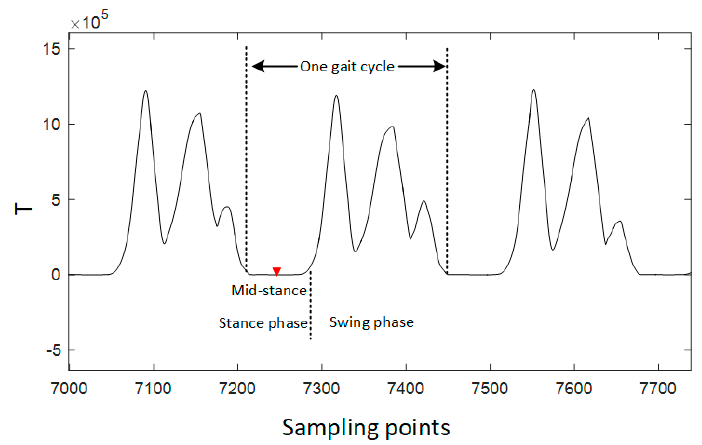
Figure 12. Relationship of mid-stance, stance phase, swing phase and gait cycle. Mid-stance can be expanded to stance phase using stance phase duration information. T is the test statics of SHOE detector.